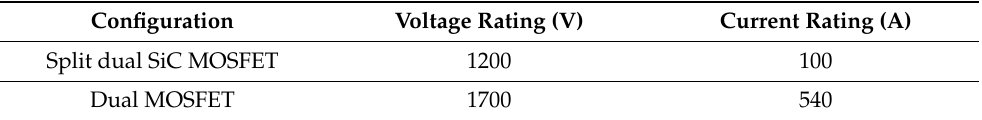
Table 18. Commercial SiC MOSFET modules by